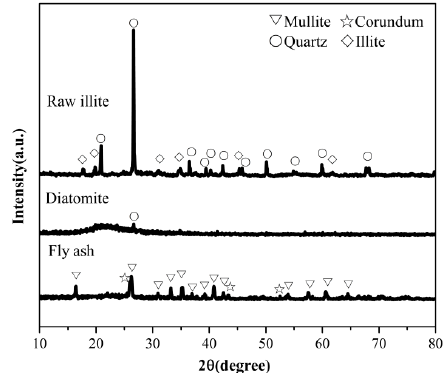
Figure 1. XRD patterns of various starting materials.